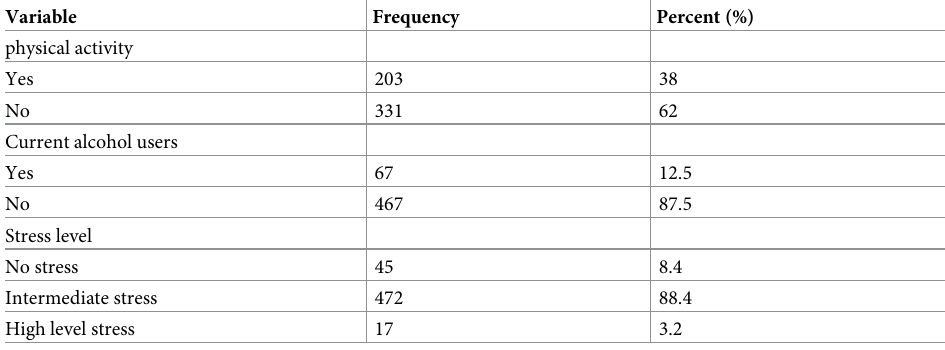
Table 3. Life style related characteristic of respondents of Mizan-Aman town, south west Ethiopia 2017. (n = 534).